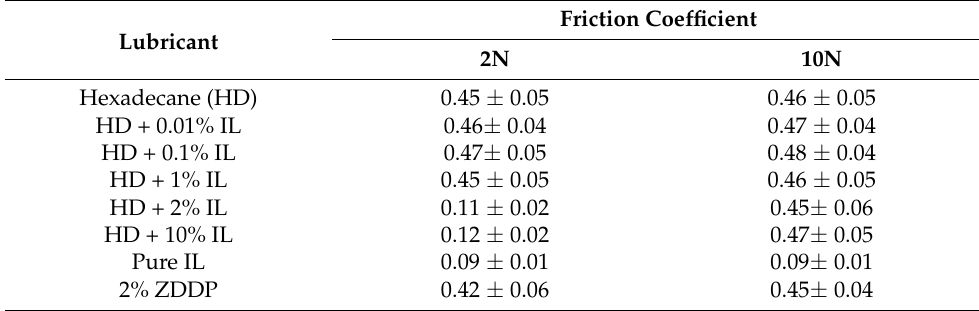
Friction Coefficient